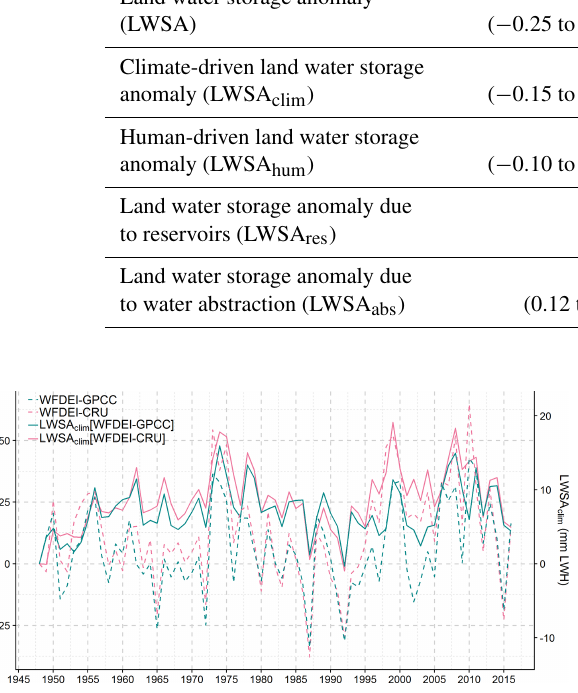
Figure 7. Correlation between global annual climate-driven LWSA and precipitation anomaly from 1948 to 2016. Pre- cipitation (rainfall plus snowfall) anomalies correspond to the WFDEI–GPCC and WFDEI–CRU forcings used in this study (Sect. 2.1.1). Climate-driven LWSA (LWSA clim [WFDEI-GPCC] and LWSA clim [WFDEI-CRU]) was obtained with the integrated WaterGAP in naturalized mode (see Table 2). Anomalies are rel- ative to the year 1948 and given in millimetres of land water height